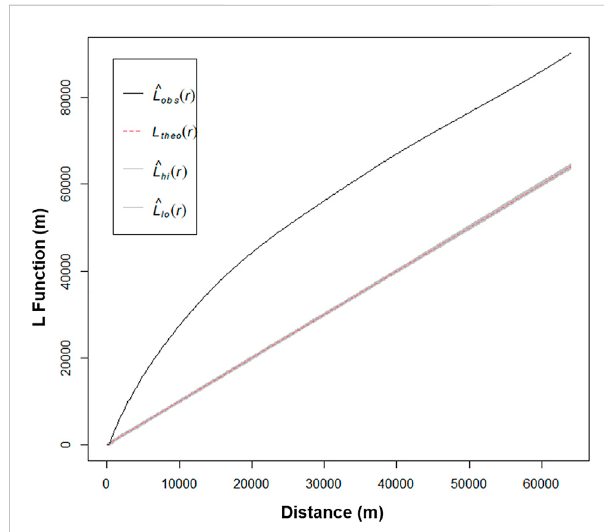
FIGURE 10 Ripley ’ s L function of submarine landslide distribution. The observed L (L obs(r) ) values are signi fi cantly higher than the expected (L theo(r) ) across different distances indicating signi fi cant clustering and inhomogeneity over various distances. The con fi dence interval (CI; L hi(r) and L hi(r) ) envelope is calculated based on 999 permutations to compare L(d) at a certain distance where points are distributed